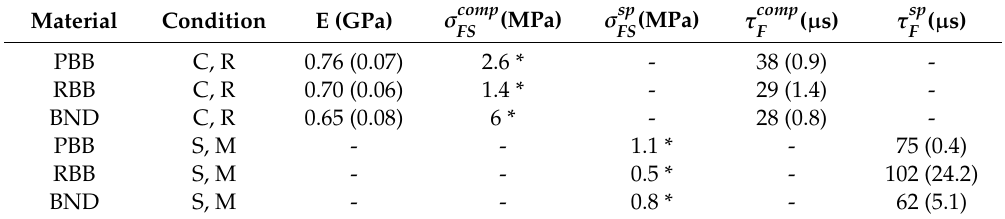
Figure 9. Calculated dependences of critical stress in bitumen binders on strain rate at compression (room temperature) ( a ) and stress rate at splitting ( − 10 °C) ( b ). Curves are calculated by Equation (3). R 2 is the coefficients of determination. Table 3. Parameters of bitumen binders: σ comp is the quasi-static compression strength; σ sp is the quasi-static splitting strength; τ comp is the incubation time of failure under compression; τ sp is the incubation time of failure under splitting; C—compression; S—splitting; R—room temperature; M—temperature of − 10 °C. Mean (standard deviation).